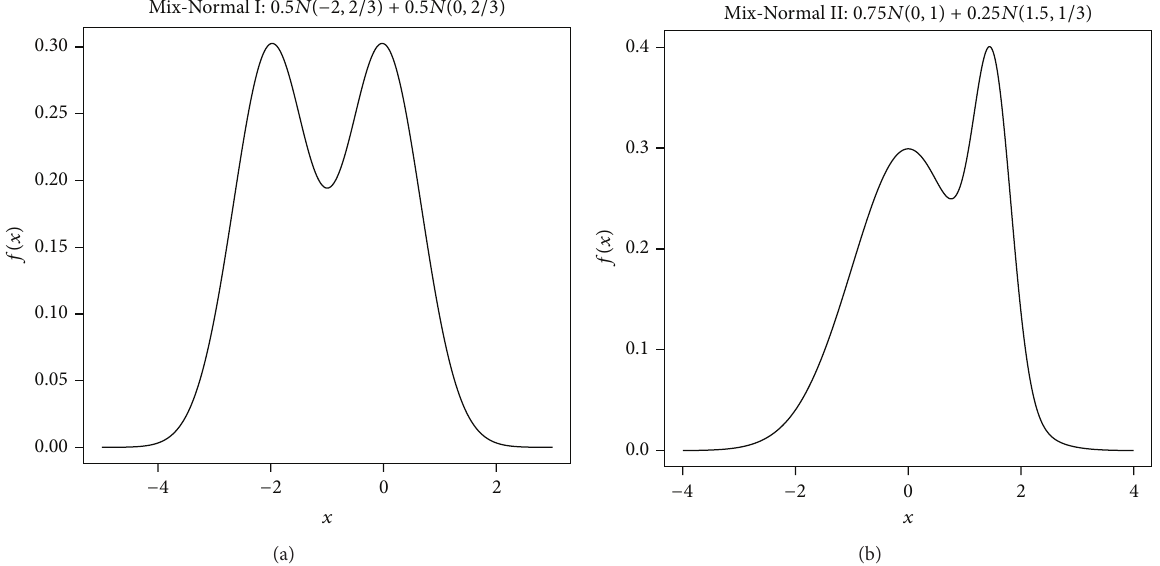
Figure 3: Density curve of (a) Mix-Normal I: ( 1 / 2 )𝑁(− 2 , 2 / 3 ) + ( 1 / 2 )𝑁( 0 , 2 / 3 ) ; (b) Mix-Normal II: ( 3 / 4 )𝑁( 0 , 1 ) + ( 1 / 2 )𝑁( 1 . 5 , 1 / 3 ) .